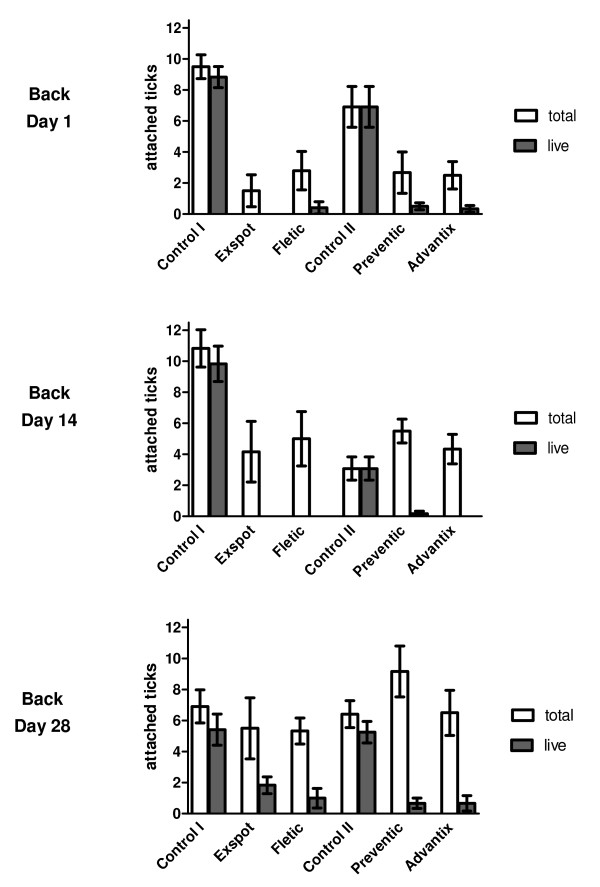
Attached ticks on the back. Figure showing the attached ticks on the back over the course of the study. The arithmetic mean of the total of attached ticks (white colour) and of the live attached ticks in particular (dark colour) can be seen for each product and for their particular control groups. The standard error of mean is included.